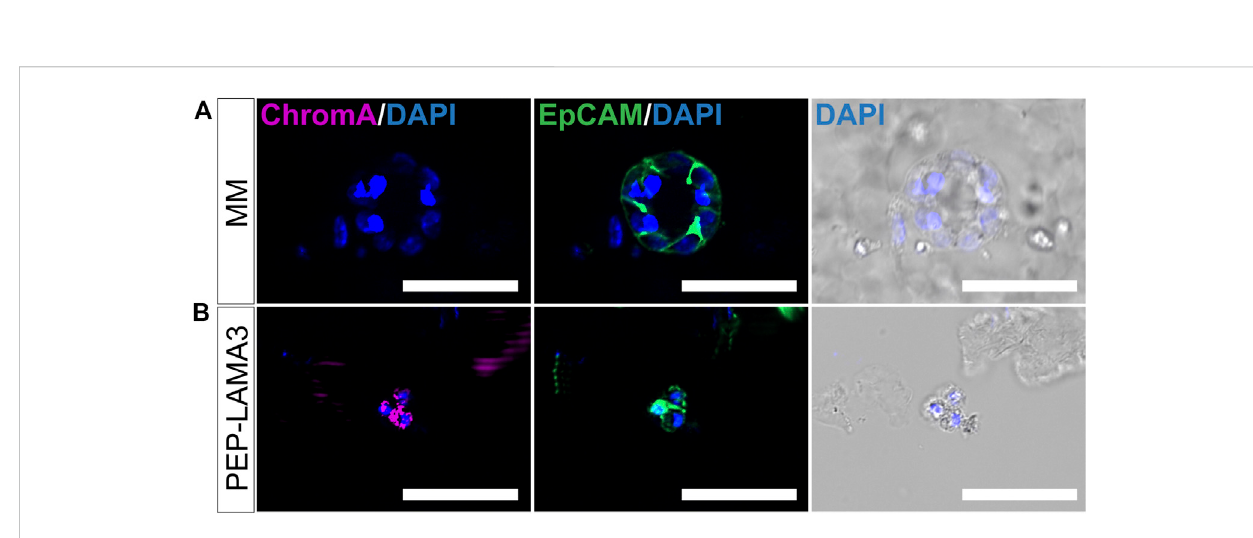
FIGURE 6 Whole-mount immuno fl uorescence staining reveals that some cells grown in PEP-LAMA3 express chromogranin A, a pan-endocrine lineage cell marker. (A) Photomicrographs of a MM ring colony stained negative for ChromA, a pan-endocrine marker, but positive for the epithelial cell marker, EpCAM (B) Photomicrographsofagrape-likecolonystainedpositiveforbothChromAandEpCAM.DAPInuclearstainingwasoverlaidwiththebright fi eld images of the colonies. Scale bars = 50